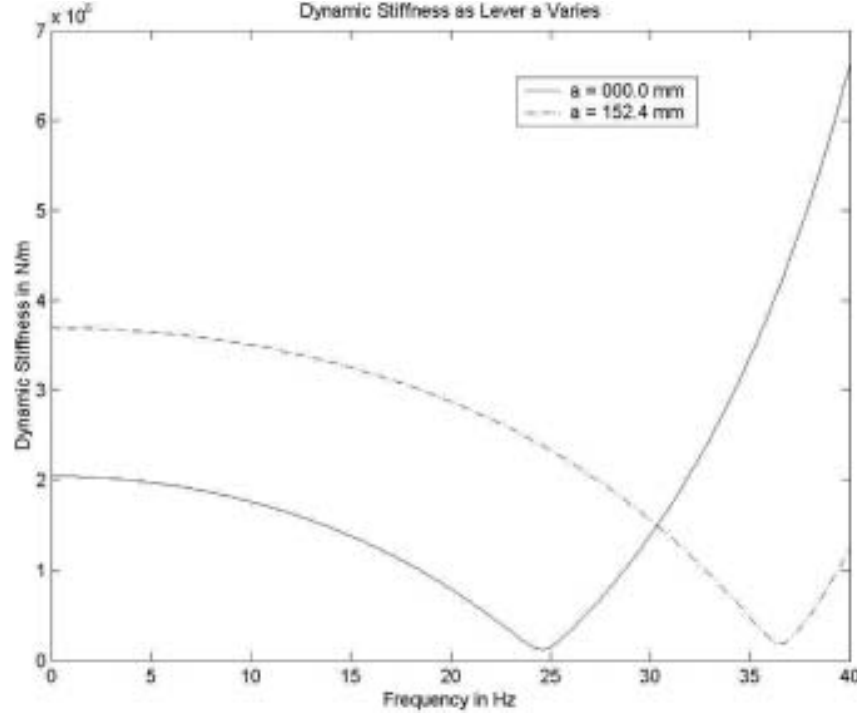
Fig. 11. Dynamic Stiffness with A m = 322 . 6 mm 2 (0.5 in 2 ) and 0 < a < 152 . 4